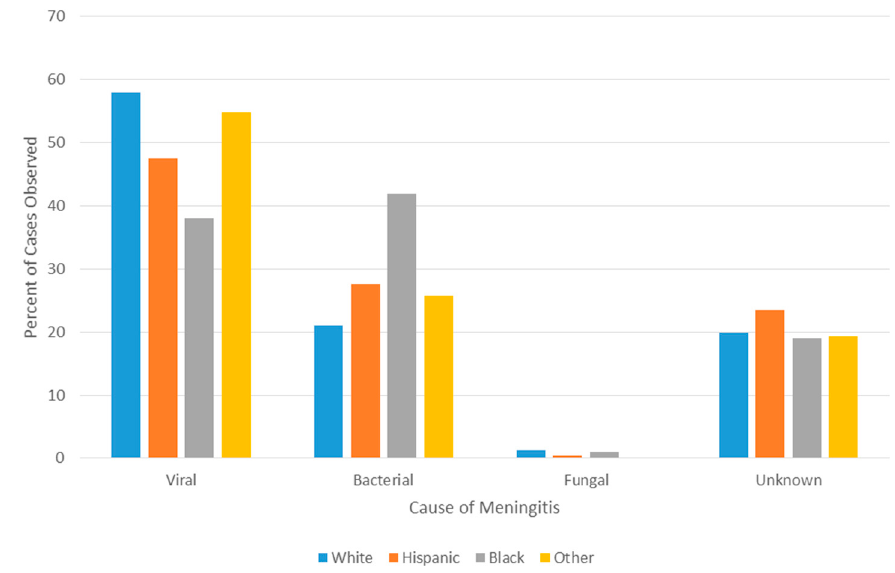
Figure 4. Meningitis cause by race.